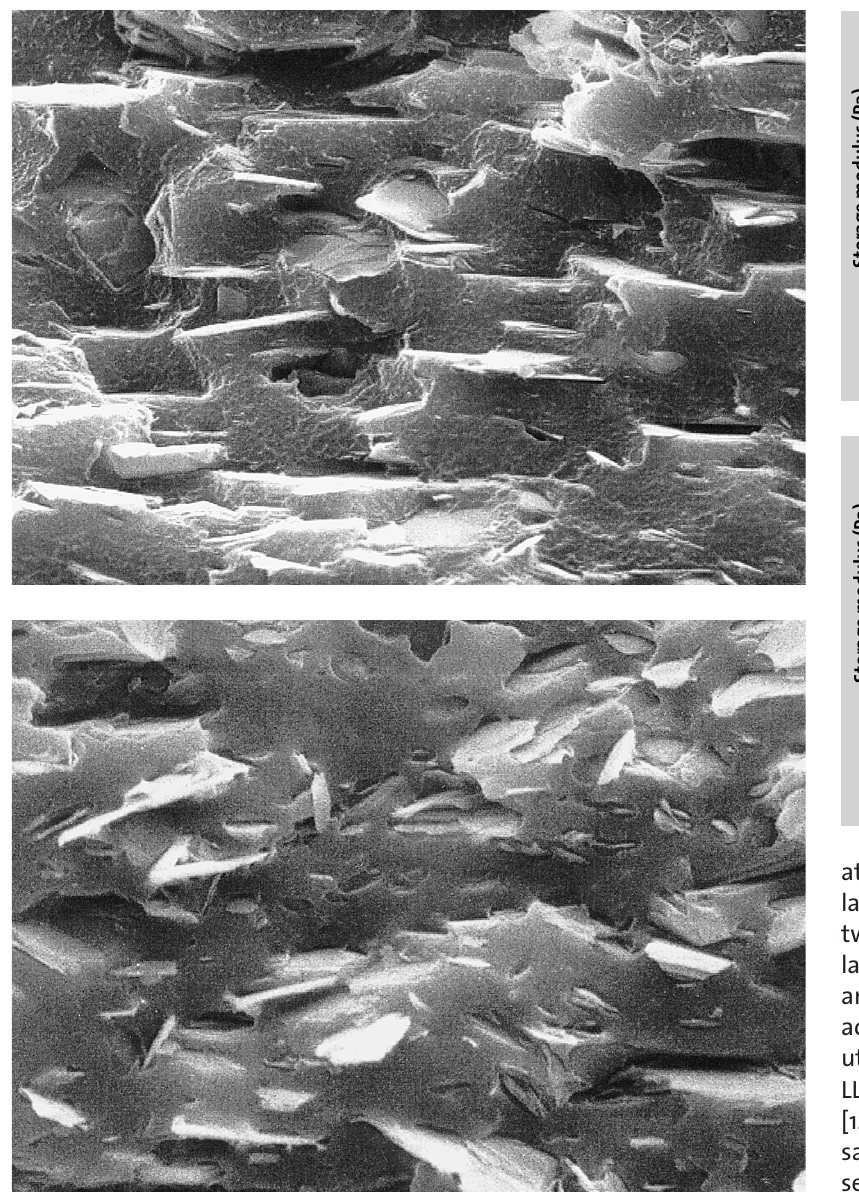
Figure 1 (left above): SEM of a cryo-fractured 8% Talc1/LLDPE composite. Figure 2 (middle): SEM of a cryo-fractured 13% Talc1/LLDPE composite. Figure 3 (right above): Changes in storage modulus with repeated strain sweeps for talc1/LLDPE composites (first sweep: Ú 8% Talc1, Ê 3% Talc1, Ï 22% Talc1; second sweep: Û 8% Talc1, Á 13% Talc1, Ì 22% Talc1). Figure 4 (right below): Changes in storage modulus with repeated strain sweeps for composites based on LLDPE and reinforced with 13% of different talcs (first sweep: Ê talc1, ‡ talc3; second sweep: Á talc1, ·